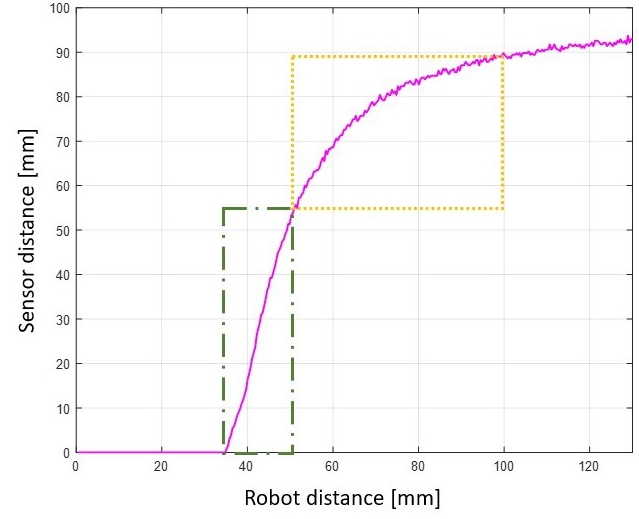
Figure 18. Characteristic curve relative to the stomach, with highlighted areas.